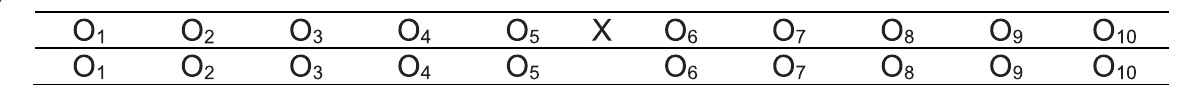
Fig. 1 Controlled interrupted time series study design. Each O represents an observed outcome value in the time series, and X represents the “interruption” when the policy took effect. The top series is considered the treated series while the bottom series is the no-treatment control